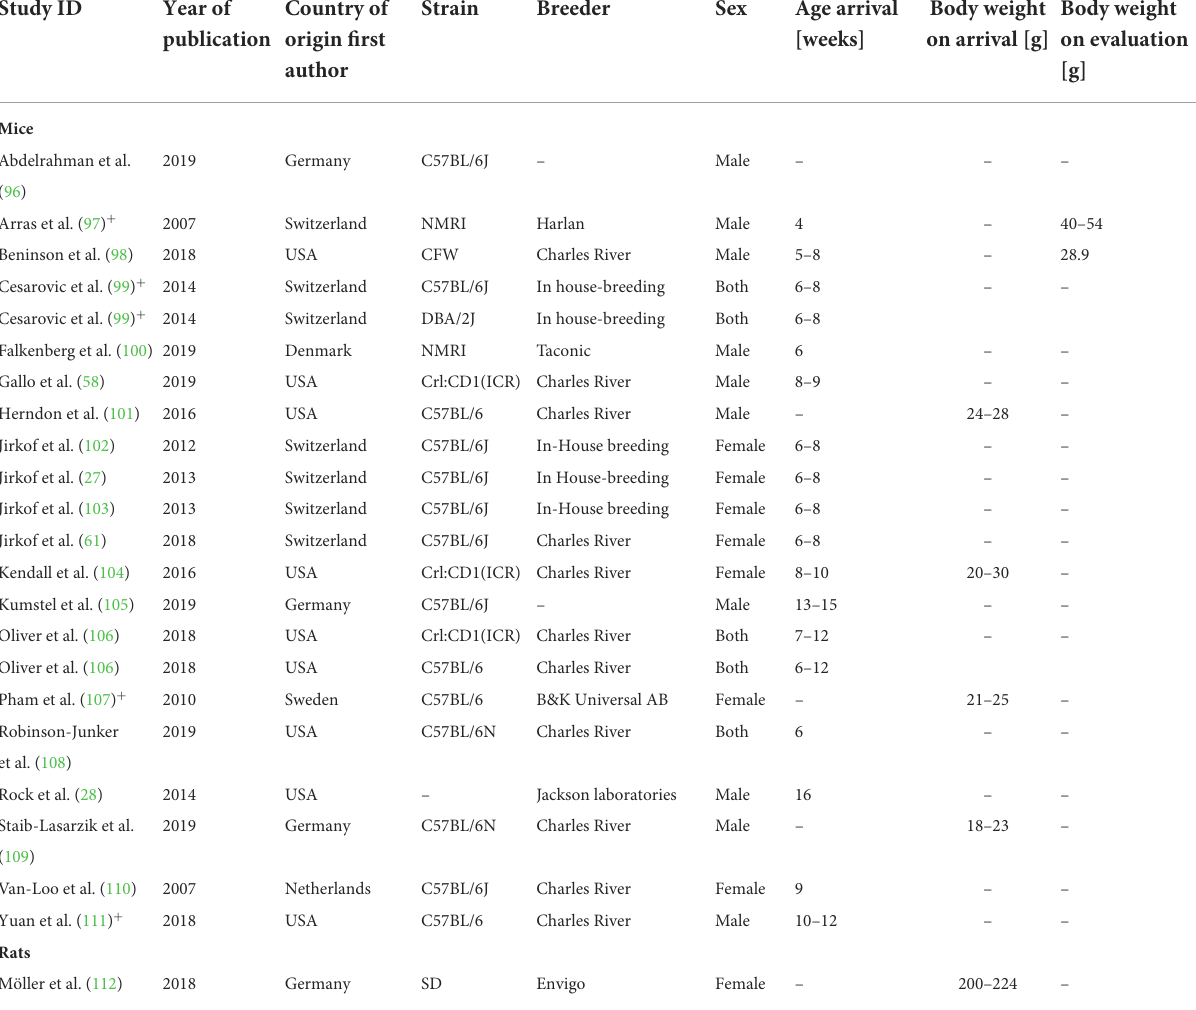
–not reported. Alphabetical characters in the Study ID indicate animal groups within individual studies [first column of the tables; e.g., Cesarovic et al. (99)]. + References were identified